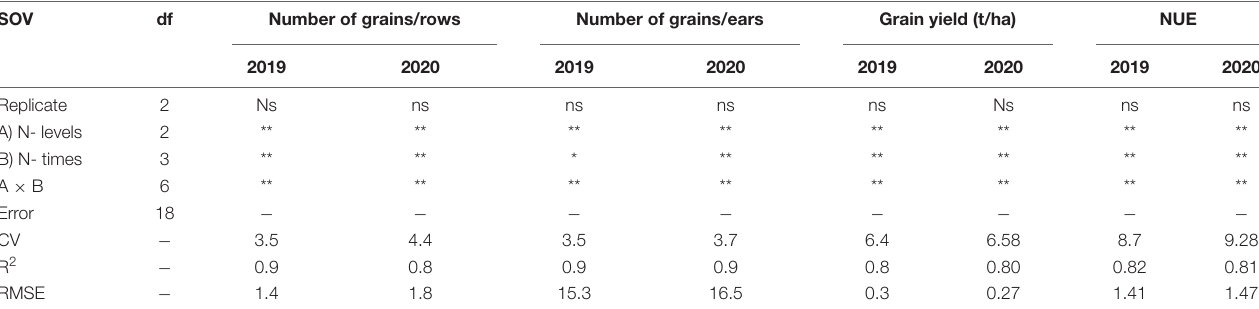
TABLE 4 | ANOVA of the effects of nitrogen rates and times of application and their interaction on number of grains/rows, number of grains/ears, grain yield (t/ha), and NUE of maize in both seasons. SOV df Number of